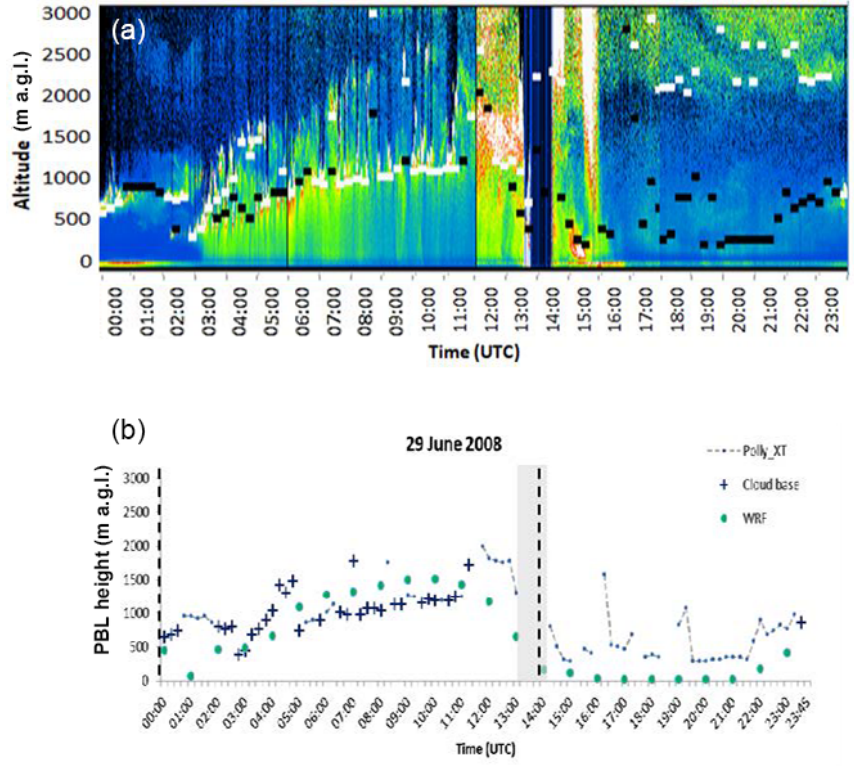
Figure 5. Same as Fig. 3 except for 29 June 2008. Grey shading (bottom) indicates